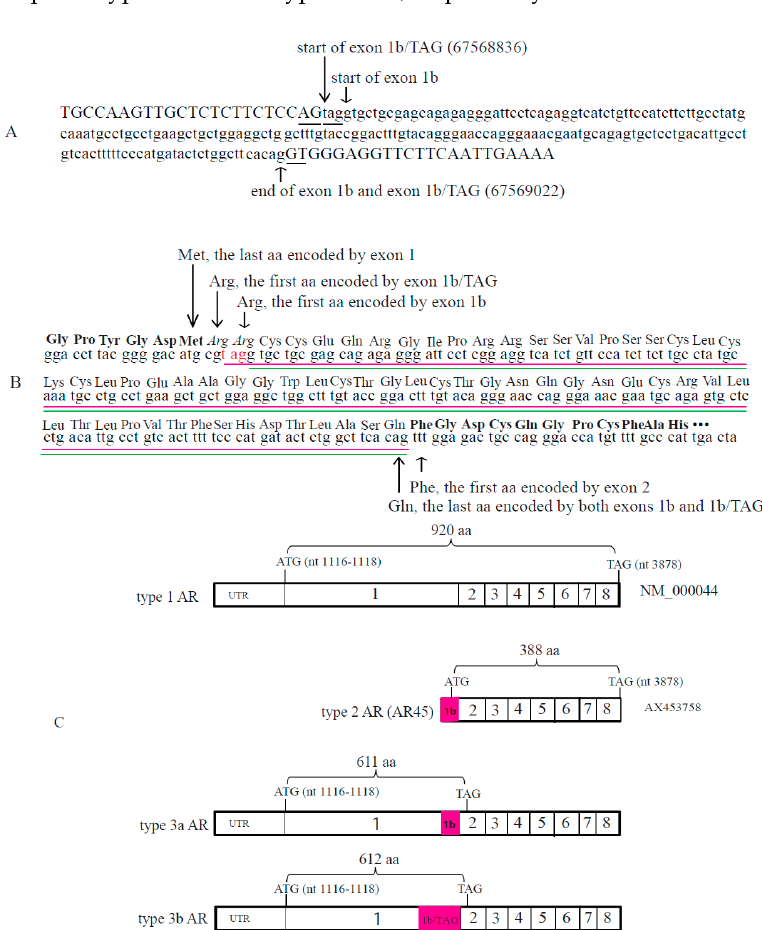
Figure 3. Genomic positions and sequences of exon 1b and exon 1b/TAG and the structures of three types of AR transcripts: ( A ) Positions and genomic sequences of exon 1b and exon 1b/TAG. Genomic coordinates are given according to GRCh38/HG38. Underlined are the dinucleotides AG and GT that position before and after exon 1b/TAG and the trinucleotide TAG of exon 1b/TAG that is upstream of exon 1b; ( B ) Predicted translation of type 3a and 3b AR variants: shown are the last six amino acids (bold) encoded by exon 1, followed 62 or 63 amino acids encoded by exon 1b (underlined in Green) or exon 1b/TAG (underlined in red), and 11-amino acids (bold) encoded by the first 33 nucleotides of exon 2. The amino acid Arginine (Arg) that is inserted because of the addition of the trinucleotide “tag” (in red) in type 3b AR and the neighbouring Arg that is present in type 3a AR are in italic; ( C ) The transcript structures of type 1, 2, 3a, and 3b ARs. Type 1, 3a, and 3b ARs have the same initiation ATG codon in exon 1 (nucleotides 1116-1118 according to AR reference sequence NM_000044). Type 1 AR transcript encodes wild-type AR protein (920 aa); Type 2 AR transcript (AX453758) uses an initiation ATG codon in exon 1b and encodes the AR45 protein (388 aa); Type 3a and type 3b AR transcripts encode type 3a (611 aa) and type 3b (612 aa) AR proteins, respectively. Of note, exon 1b and exon 2 are translated in a different frame in type 3a/b AR than in type 2 AR. Exon 1b or exon 1b/TAG is highlighted in red. UTR, untranslated region.